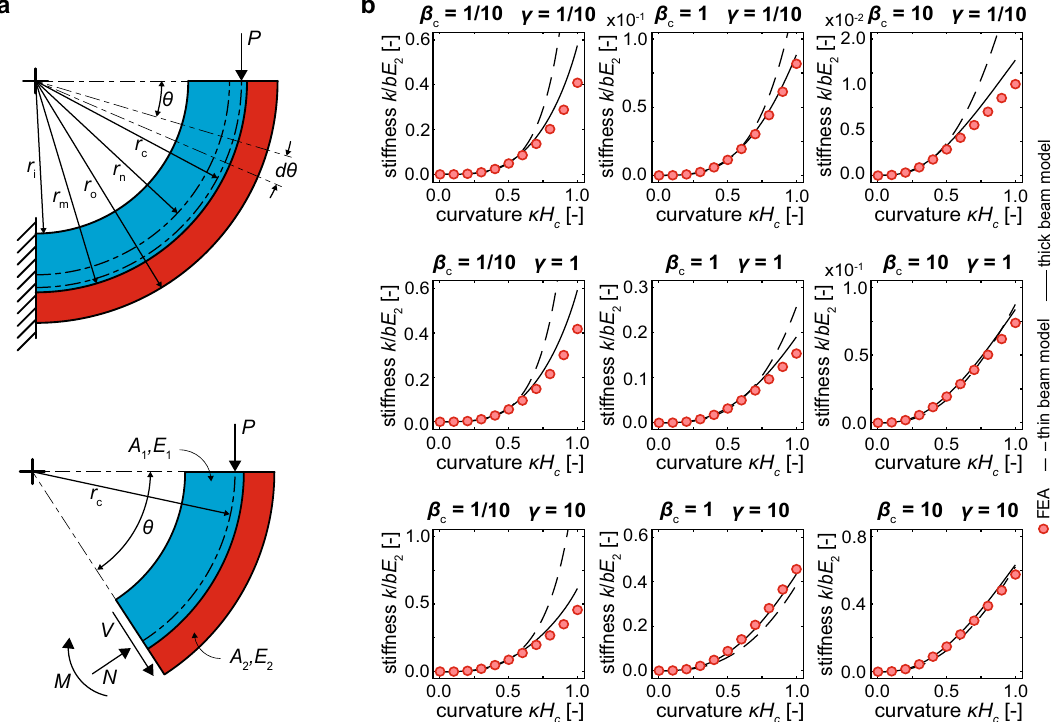
Fig. 3 Stiffness analysis of curved bilayer elements. a A schematic illustration of a folded bilayer specimen. b Theoretical and FEA results for bilayers with varying thickness ratio, β c , and stiffness ratio, γ